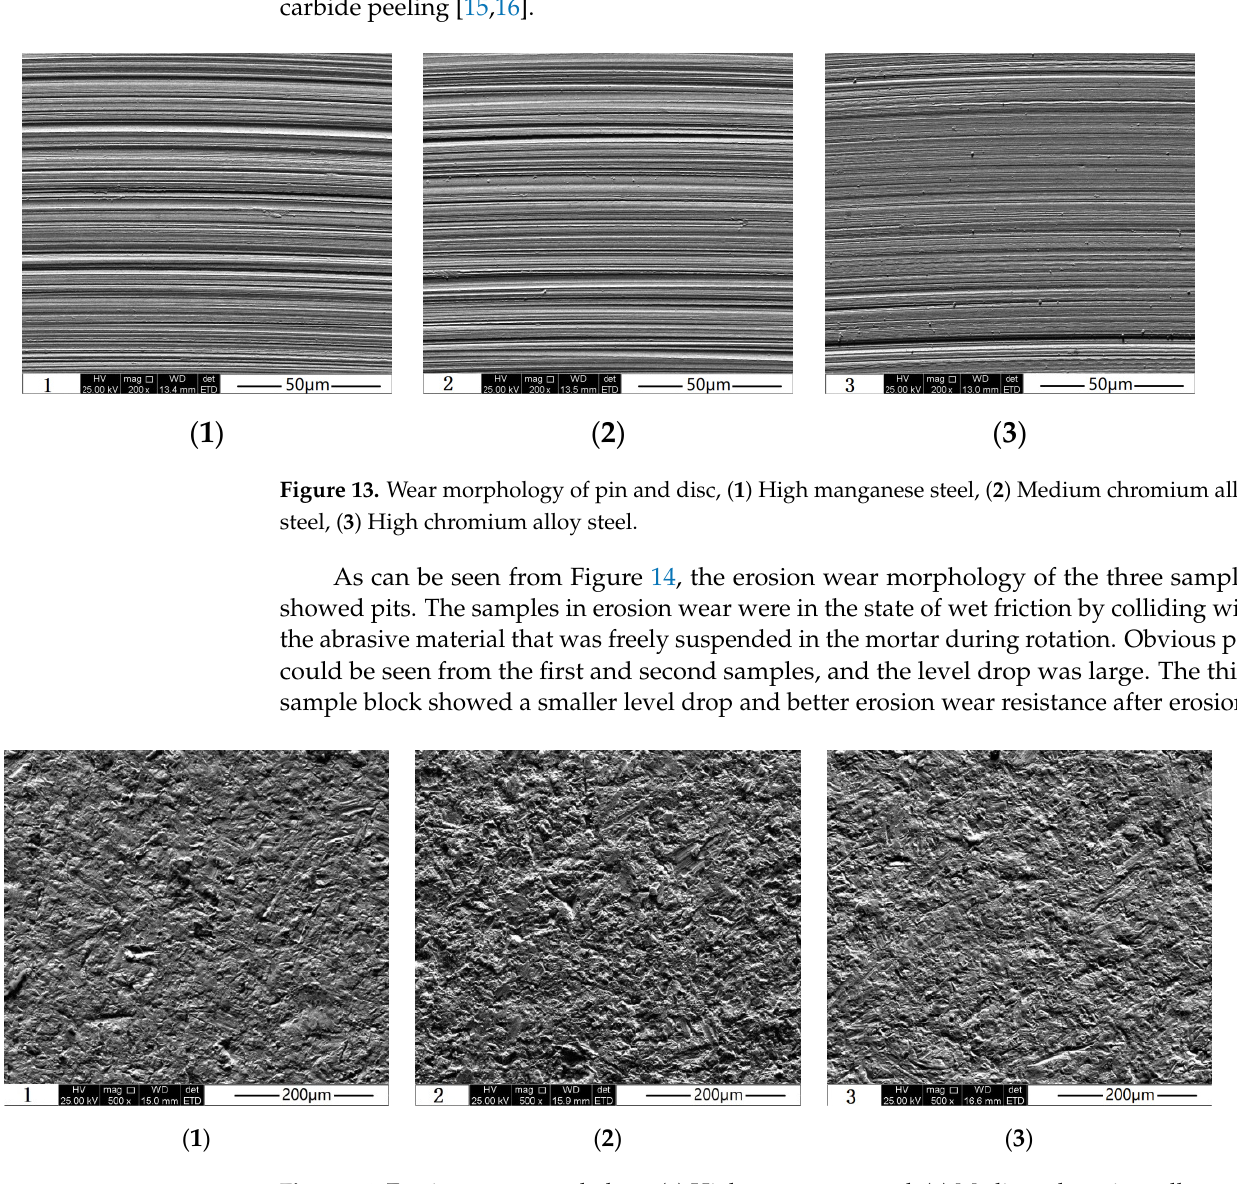
Figure 14. Erosion wear morphology, ( 1 ) High manganese steel, ( 2 ) Medium chromium alloy steel, ( 3 ) High chromium alloy steel.